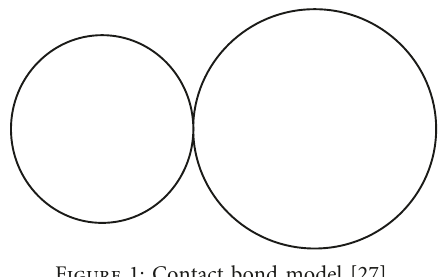
Figure 1: Contact bond model [27].